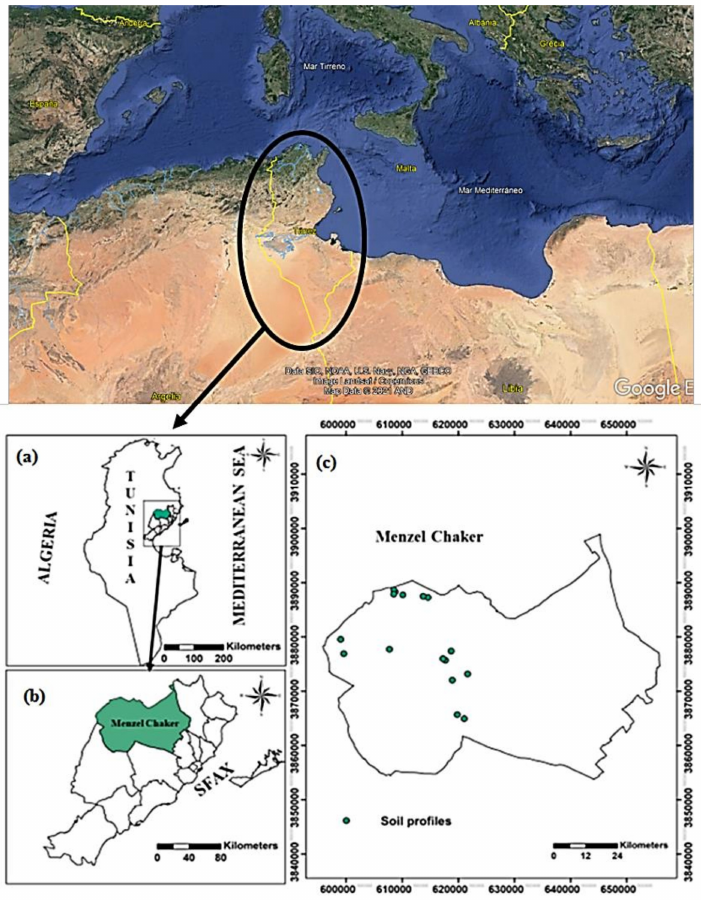
Figure 1. Maps of the study area: ( a ) Tunisia map, ( b ) Sfax location, and ( c ) Menzel-Chaker district with the location of soil profiles https://earth.google.com/web/@36.6638314,7.9704552,553.33197981 a,3949044.97759938d,35y,0h,0t,0r (Google Earth Pro—Access: 27 September